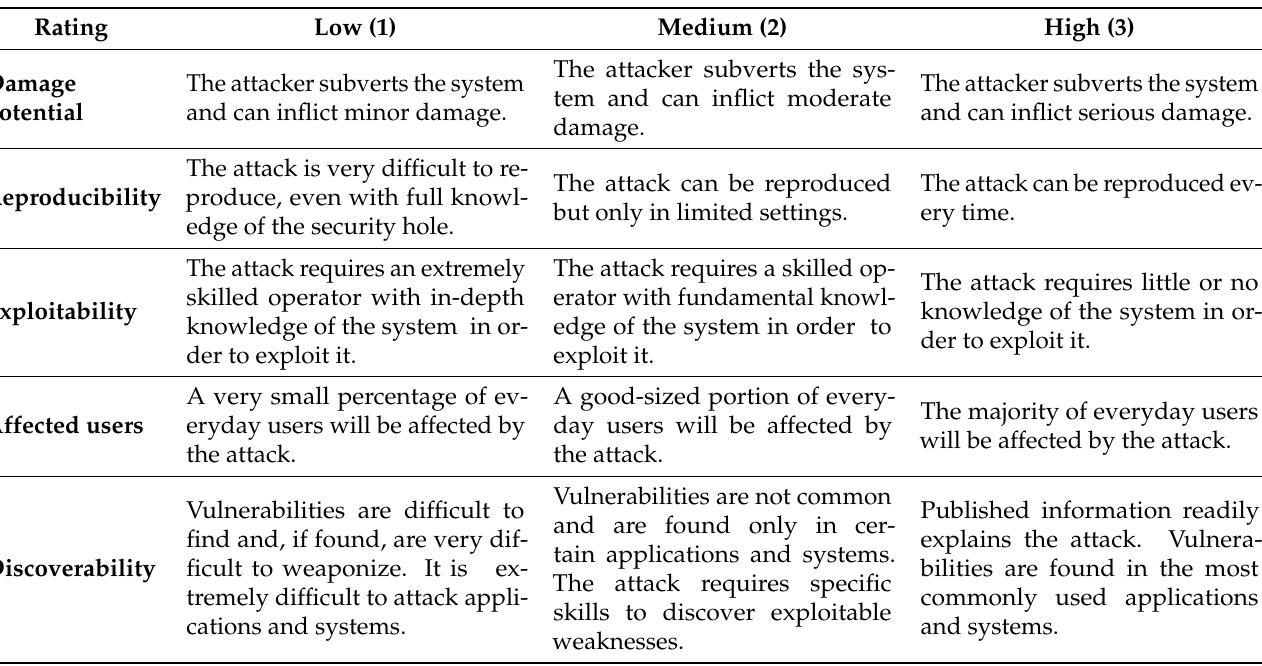
Table 1. Descriptions of the DREAD model’s key